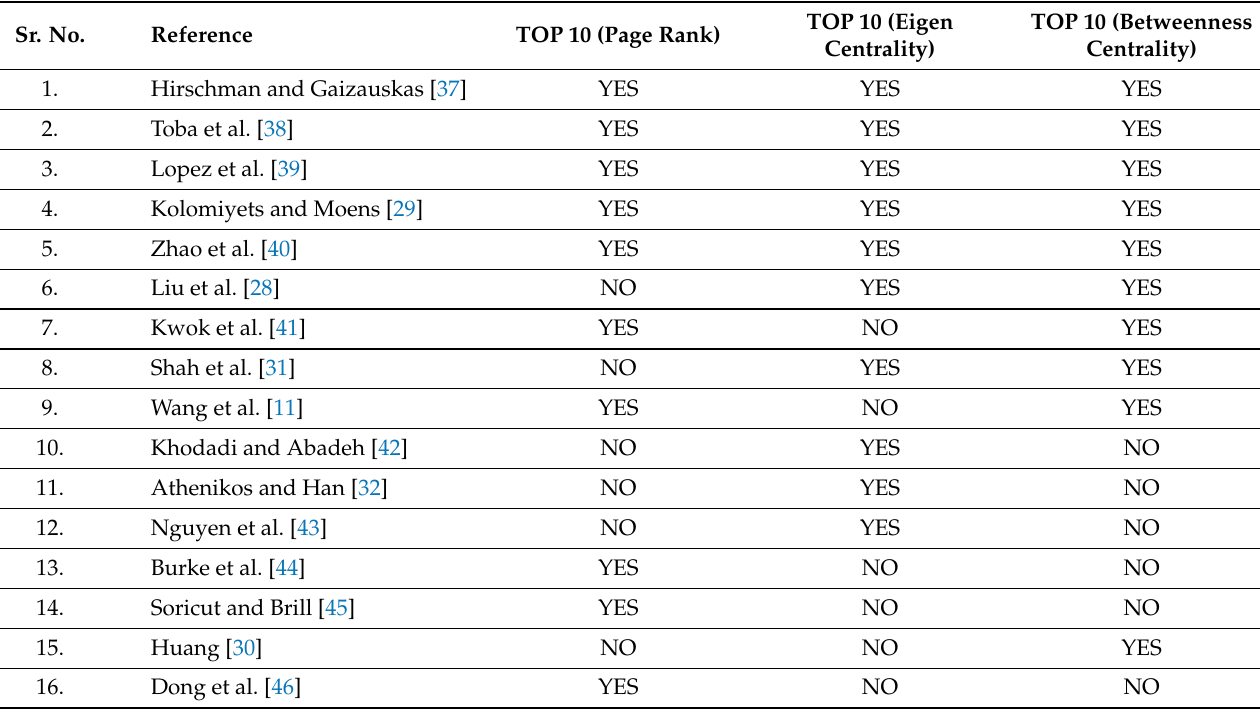
Table 6. Citation Analysis (SCOPUS).